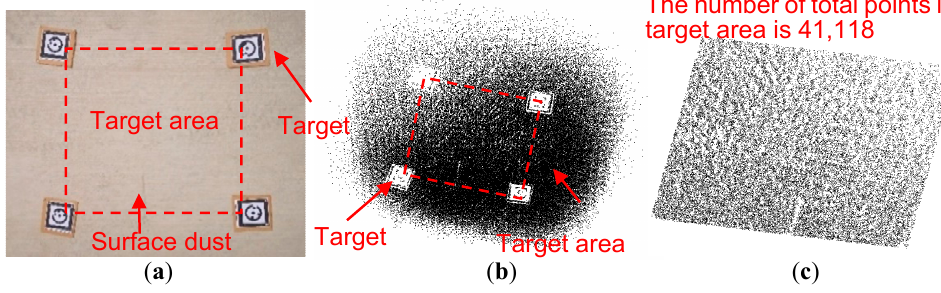
Figure 7. ( a ) The photo of the flat concrete pavement, ( b ) the original point cloud and ( c ) the original point cloud within in the target nal point cloud within in the target area. Table 3. The denoising results of the concrete pavement point cloud without foreign body noise points by different denoising parameters.